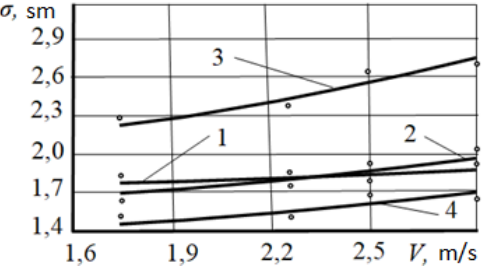
Figure 7. Influence of the speed of movement of the unit and the technological scheme of the tool on the standard deviation of the depth of processing (Background -